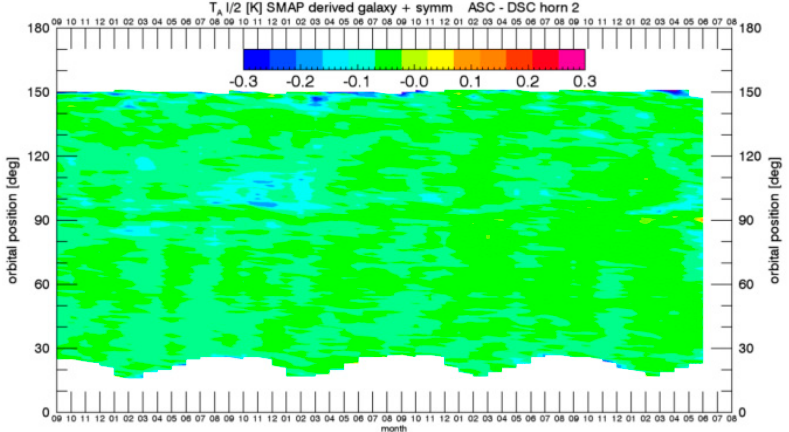
Figure 6 . ( a ) Reflected galactic radiation computed from the GO model for an average wind speed of 7.5 m/s. ( b ) Value of the empirical symmetrization Δ derived in this section. The figures show the 1 ( ) T T + (in Kelvin) as function of time (day of year) and orbital position values of the averages , . 2 A V A H ( z -angle) for Aquarius horn 2.